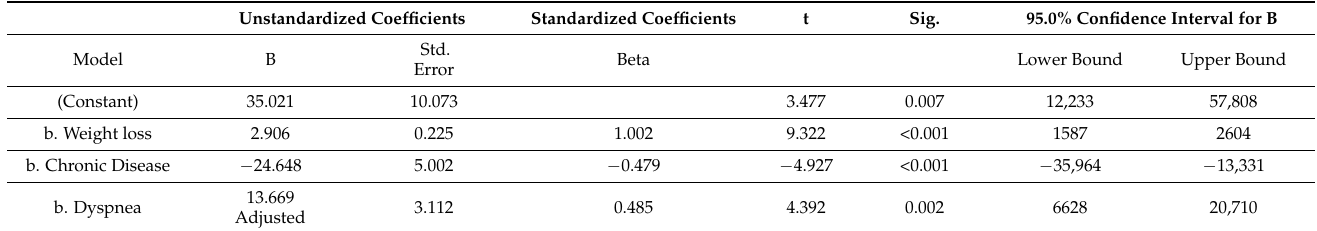
Table 7. Multiple linear regression model to predict a faster recovery time